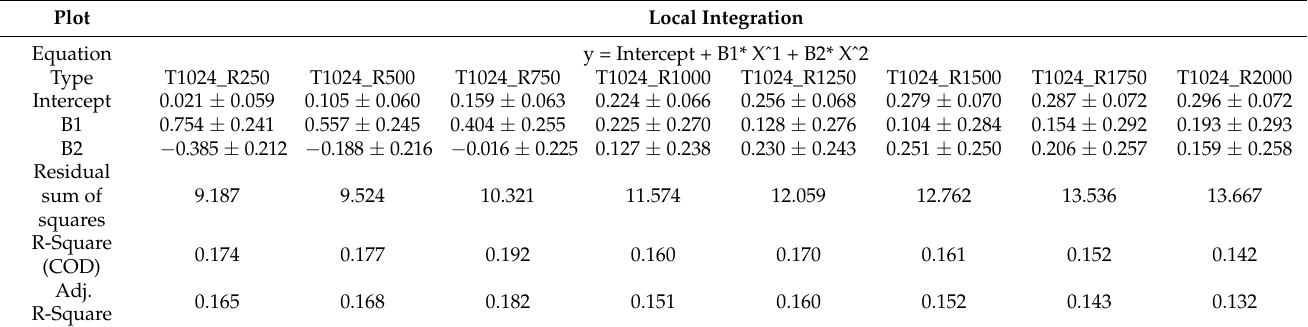
Table 9. Local integration and through angle and limit distance range polynomial curve fitting